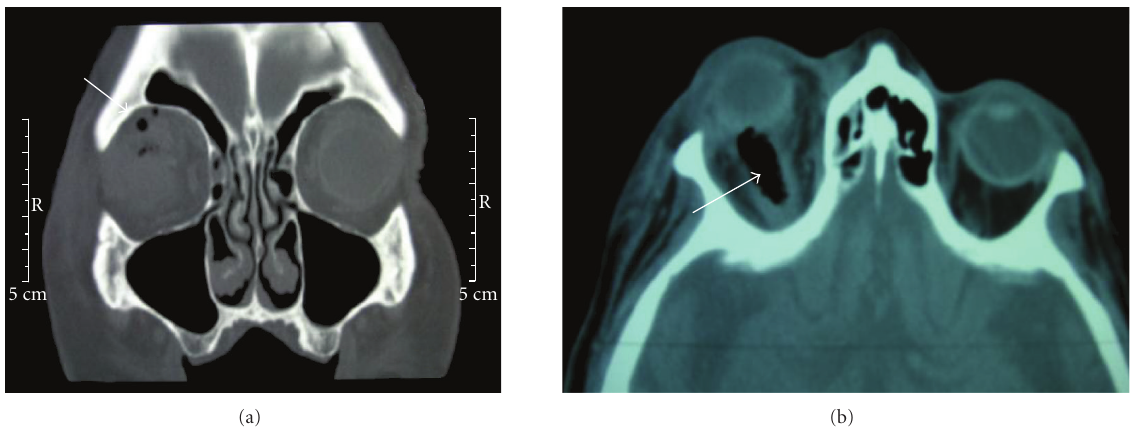
Figure 1: CT at the admission. (a) The arrow indicates extraconal air bubbles, (b) intra-conal air bublle.